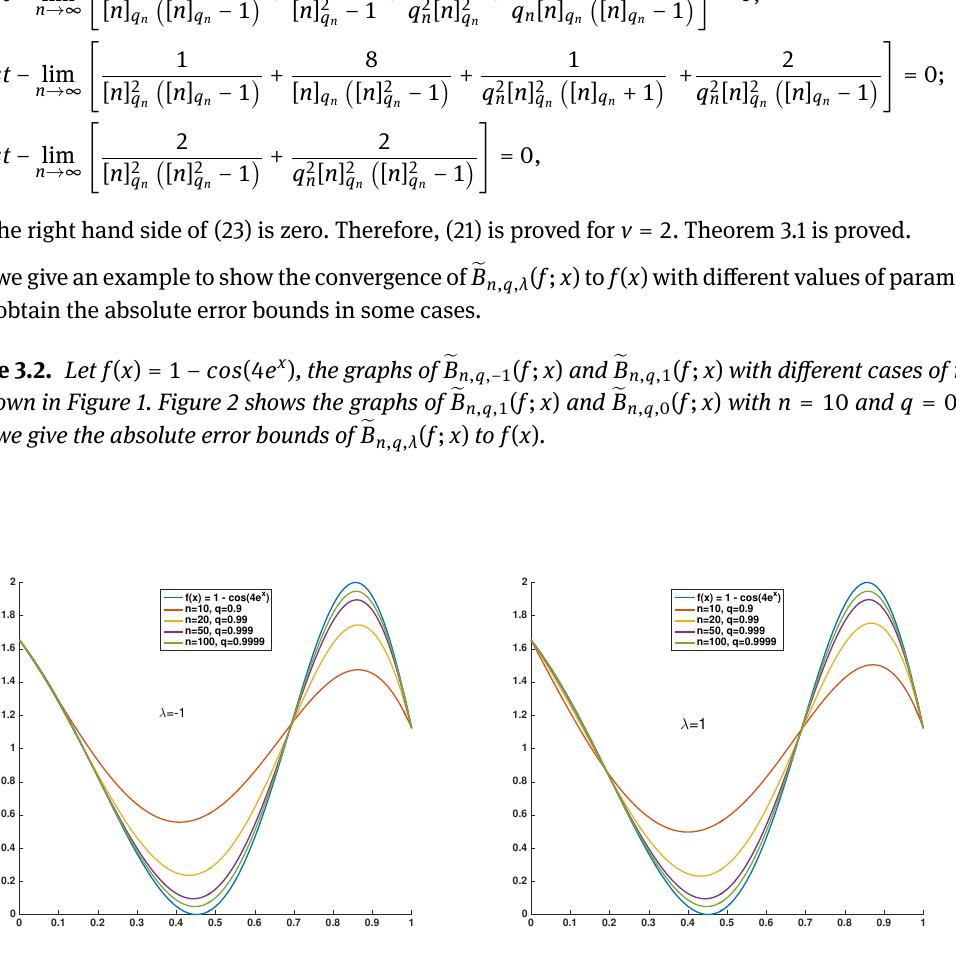
Figure 1: Convergence of (cid:101) B n , q , λ ( f ; x ) for λ = −1, λ = 1 and different values of q and n .